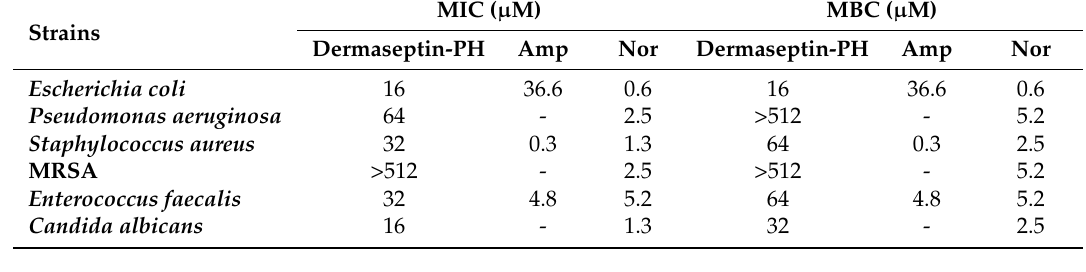
Table 1. Minimum inhibitory concentrations (MICs) and minimum bactericidal concentrations (MBCs) of Dermaseptin-PH, ampicillin (Amp) and norfloxacin (Nor) against tested microbes.